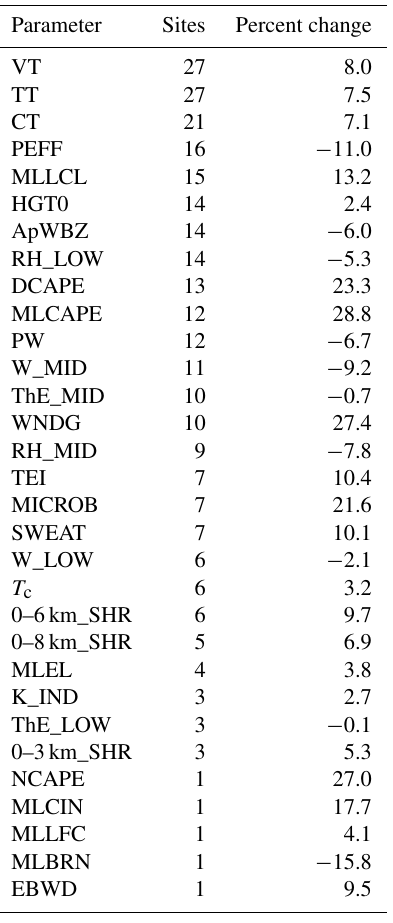
Table 6. Same as Table 5, except for SHS